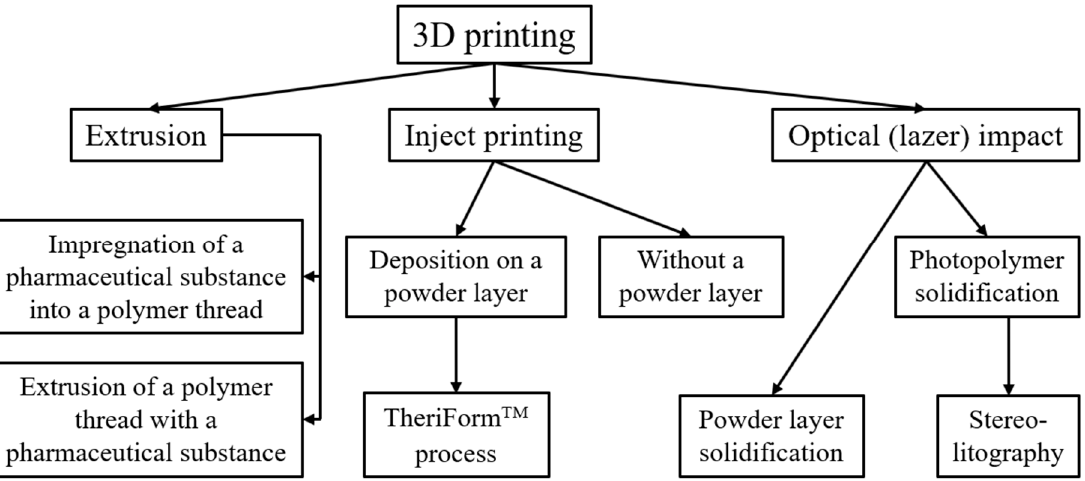
Figure 1. Classification of 3D printing methods.